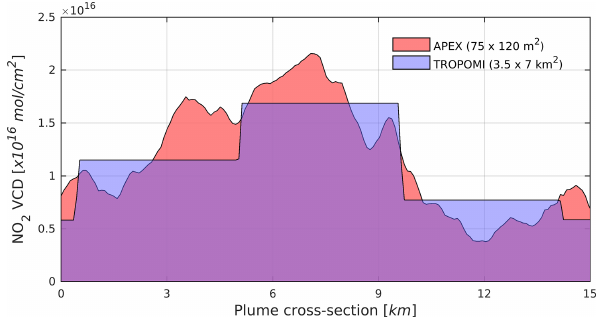
Figure 12. APEX and TROPOMI NO 2 VCDs along a southwest– northeast 15km cross section taken perpendicular to the major NO 2 plume retrieved over Antwerp on 29 June 2019. Approximately five TROPOMI pixels and 150 APEX pixels are